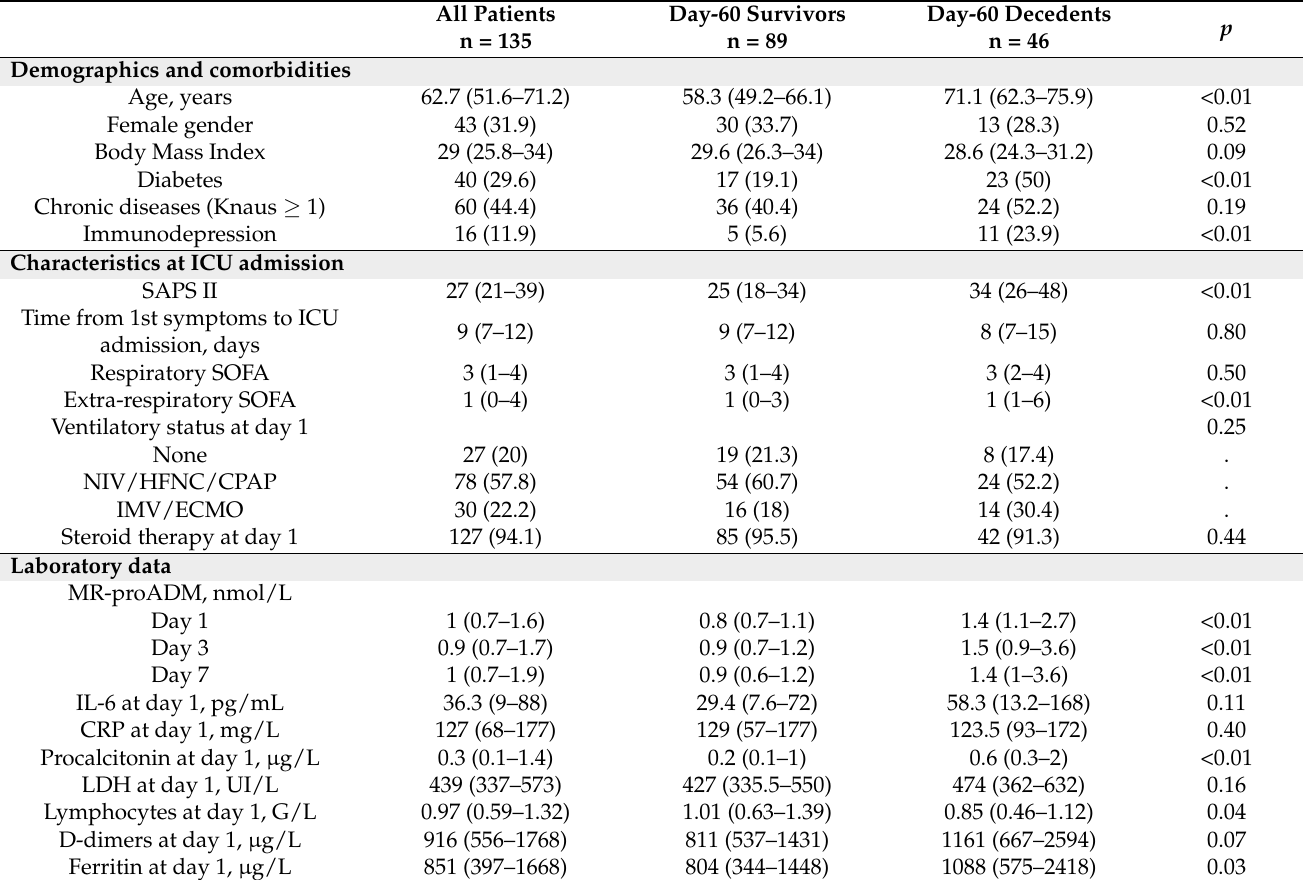
Table 1. Population characteristics at ICU admission.